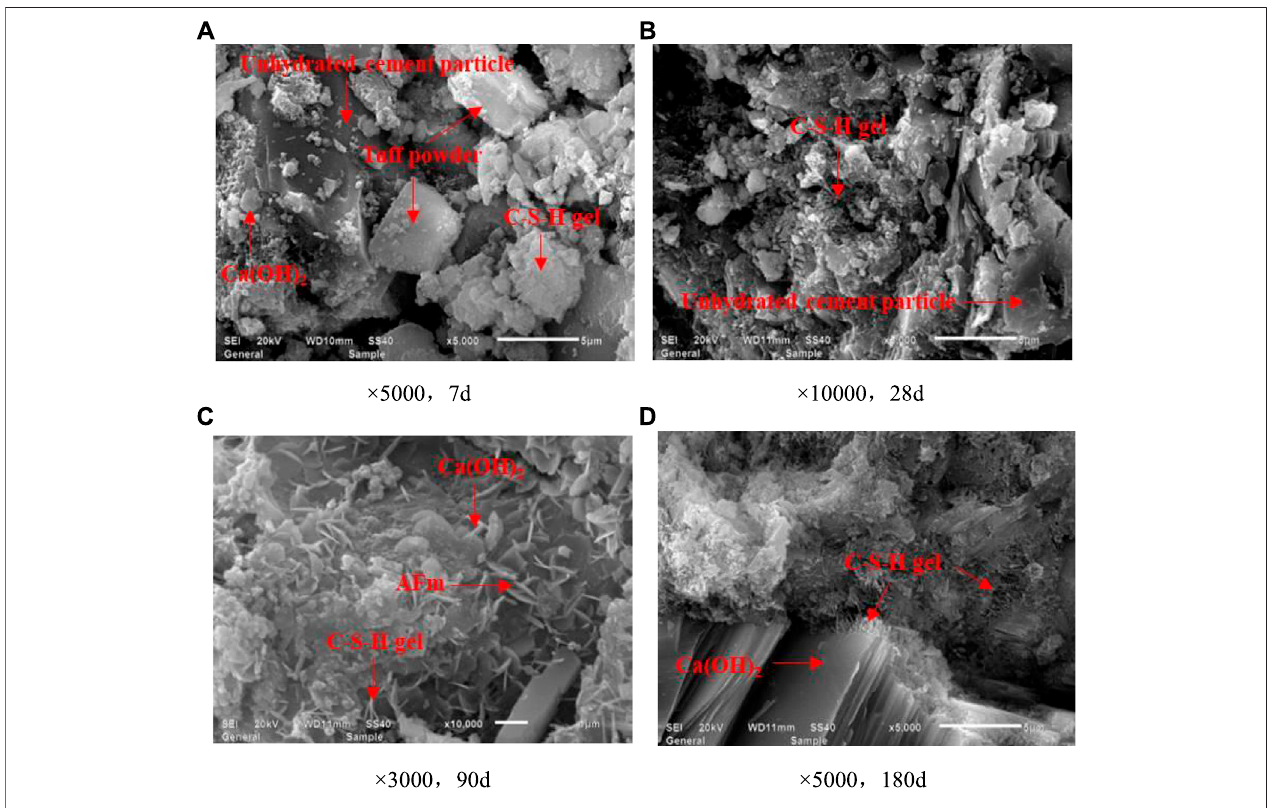
FIGURE 11 | SEM images of hardened paste of NH3 (50% Tuff powder).